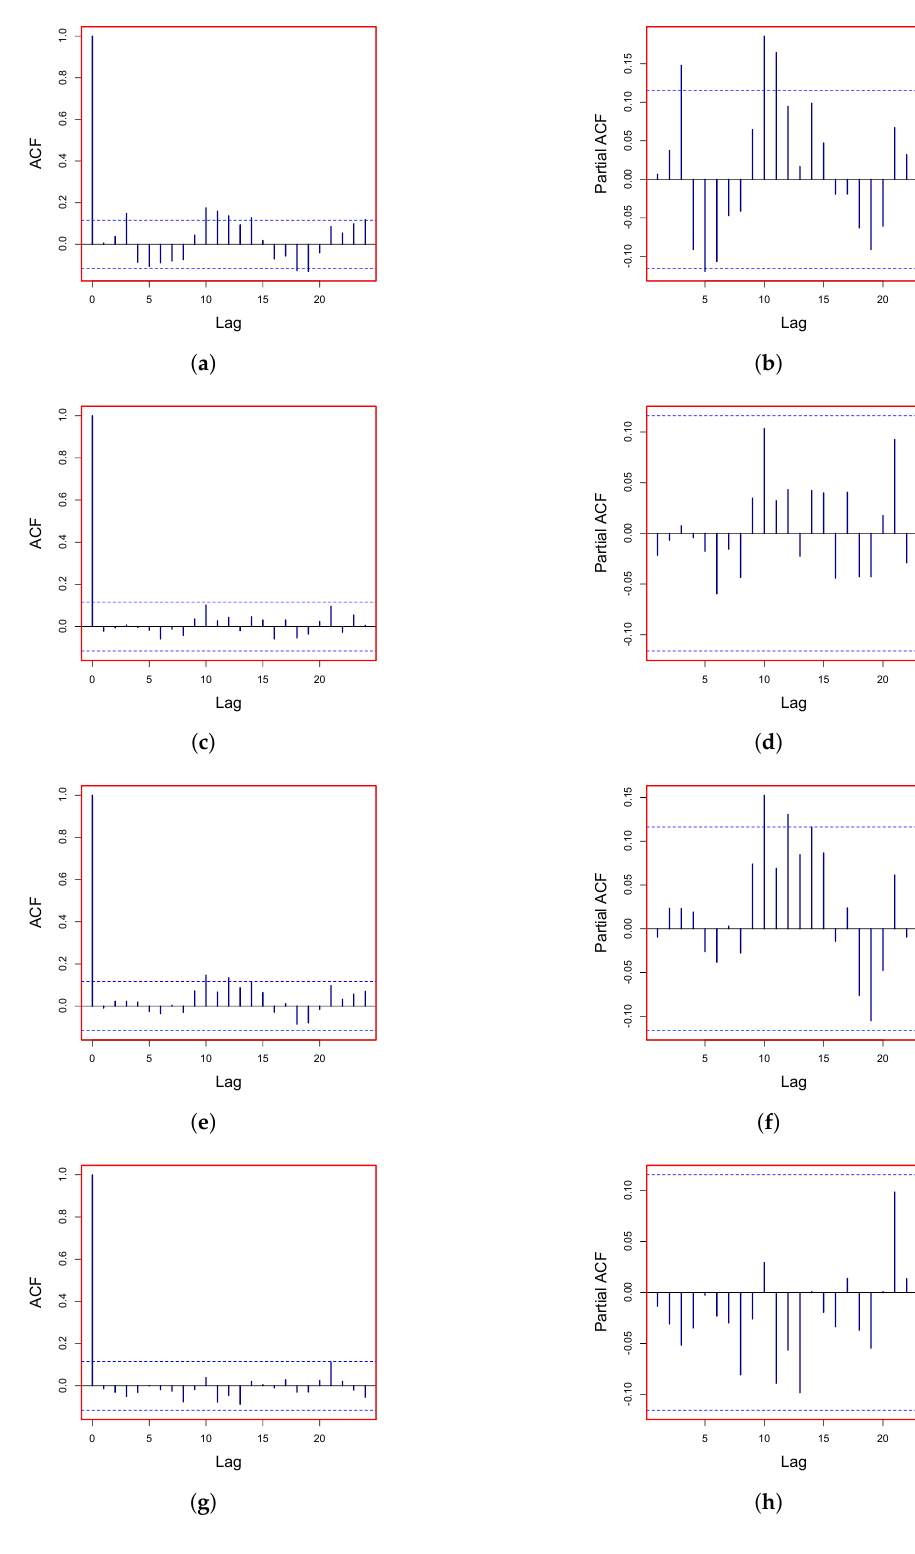
Figure 6. ACF and PACF for the final (cid:101) t for P-AR ( a , b ), P-NPAR ( c , d ), P-STAR ( e , f ) and P-ARMA ( g , h